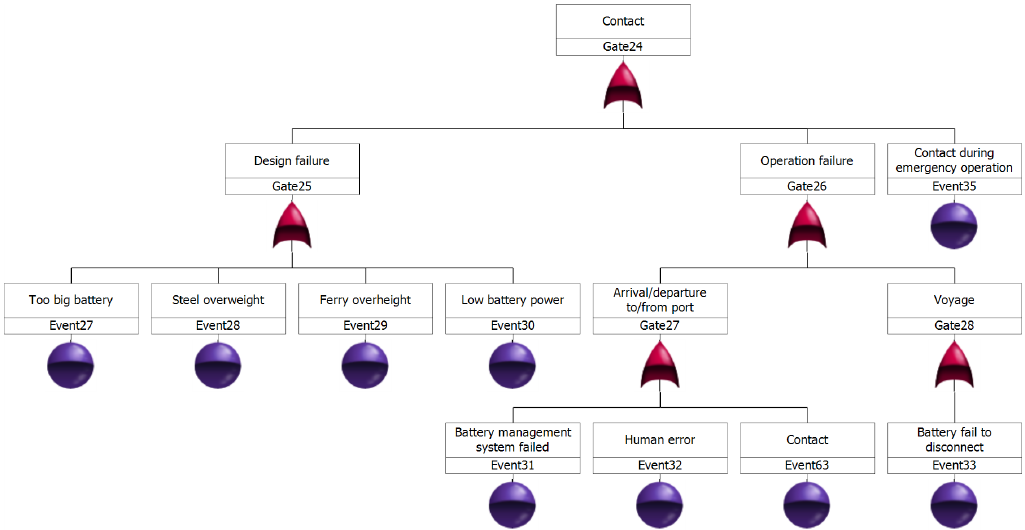
Figure 8. Fault tree analysis on hazard associate with contact.